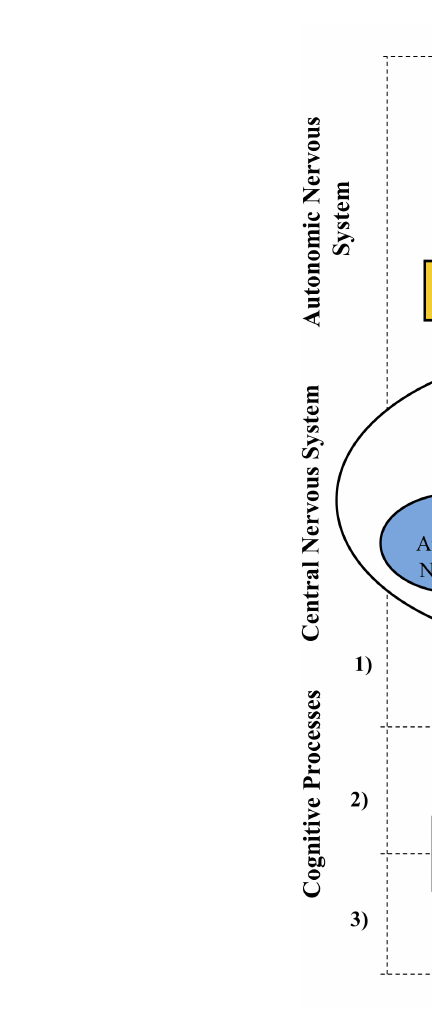
FIGURE5 The self-regulation-self-referential-memory (SR-SRM) model. Autonomic control can be exercised through HRV self-regulation training and thus affects pathways of the autonomic nervous system which reach the central nervous system. These pathways connect via the brainstem with several forebrain structures in the central autonomic network. Due to shared structures (most notably the vmPFC) further brain networks are influenced down the line which are involved in self-referential information processing (1.1). Likewise, affective processing is affected by functional changes related to limbic structures (1.2) which in turn influence self-referential processing (1.3). Firstly, self-referential encoding (2.1) provides a memory advantage to the encoded information (3.1). Secondly, self-referential processes are associated with the internal focus on thoughts that can trigger reactivation of a new memory or add novel associations to it, especially when the memory is related to the self (2.2), supporting its consolidation and retrieval (3.2). Consequently, strengthening self-referential processing via HRV self-regulation training may support voluntary retrieval of memory. In this context, biofeedback acts as a moderator because it facilitates self-regulation. vmPFC, ventromedial prefrontal cortex; HRV, heart rate